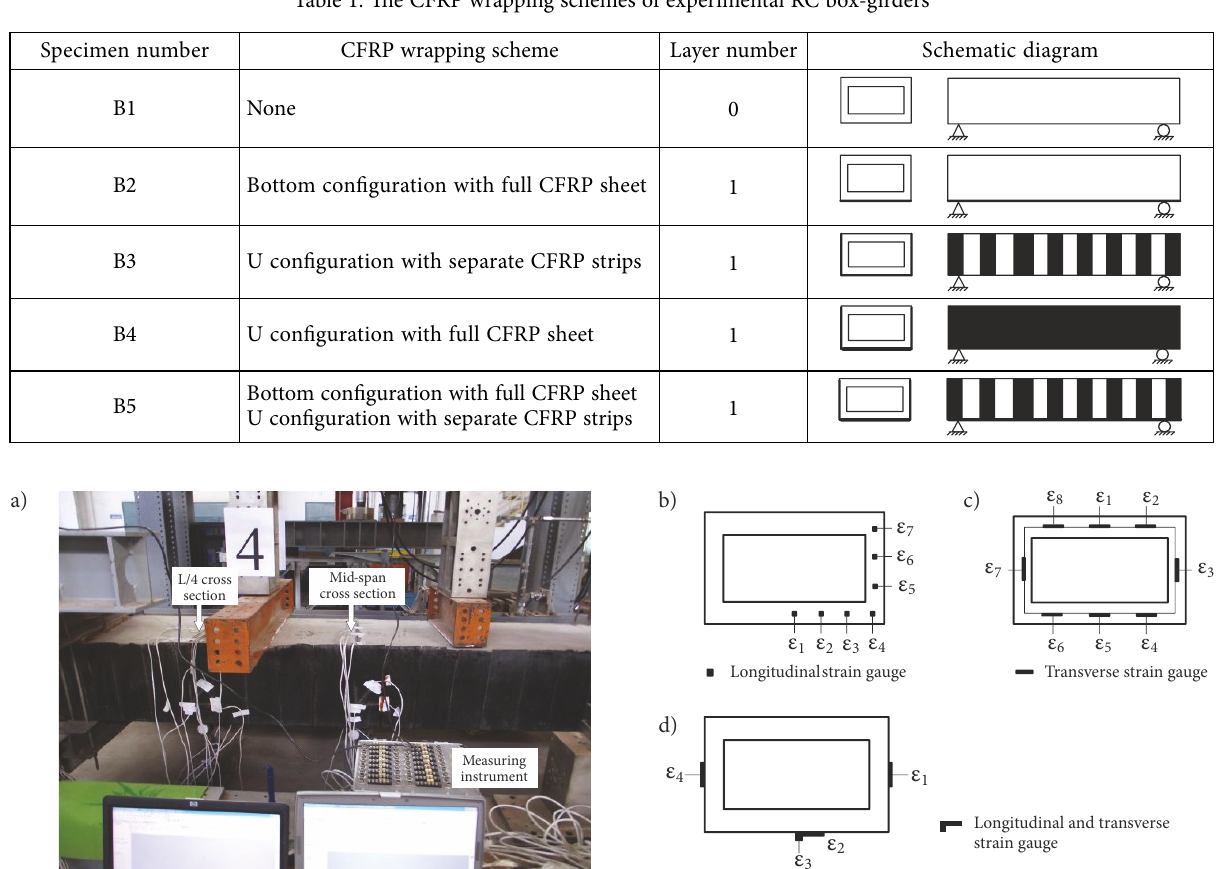
Figure 1. Geometric configuration of the experimental RC box-girder (units: mm): a – geometric shape and sizes of the RC box-girder; b – the reinforcement distribution, shape and sizes of cross Table 1. The CFRP wrapping schemes of experimental RC box-girders